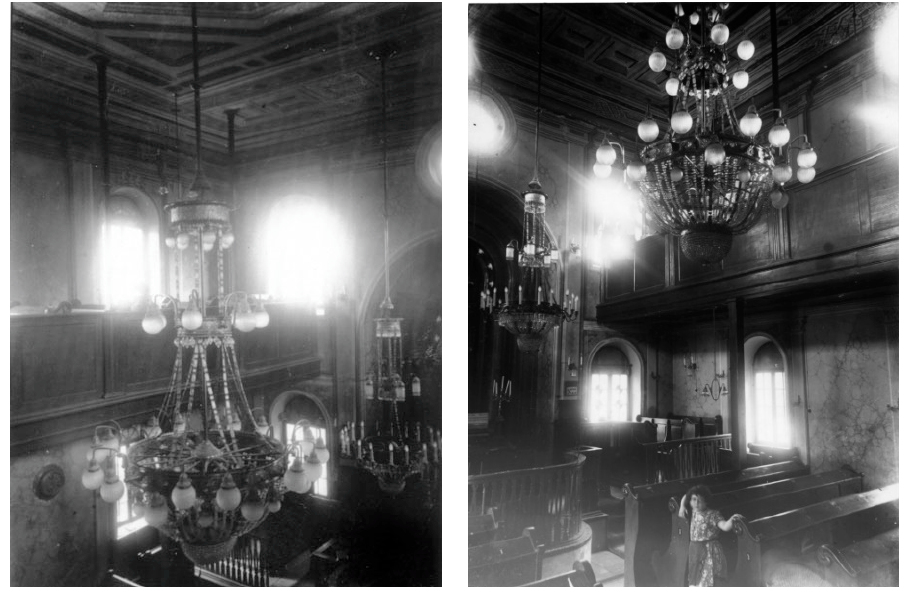
Figure 7. Zemun synagogue interior before WWII.